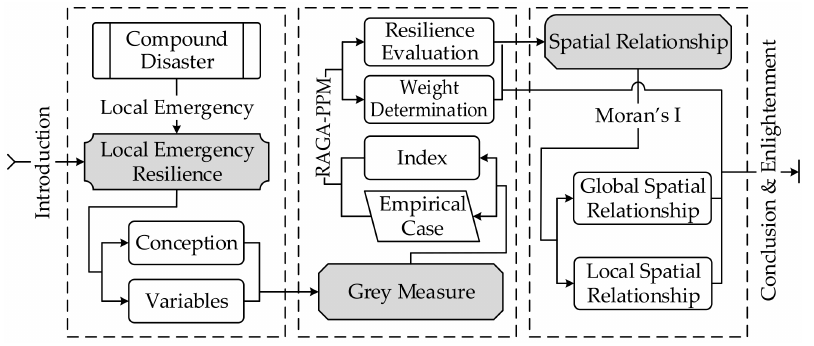
Figure 1. The analytical framework of this